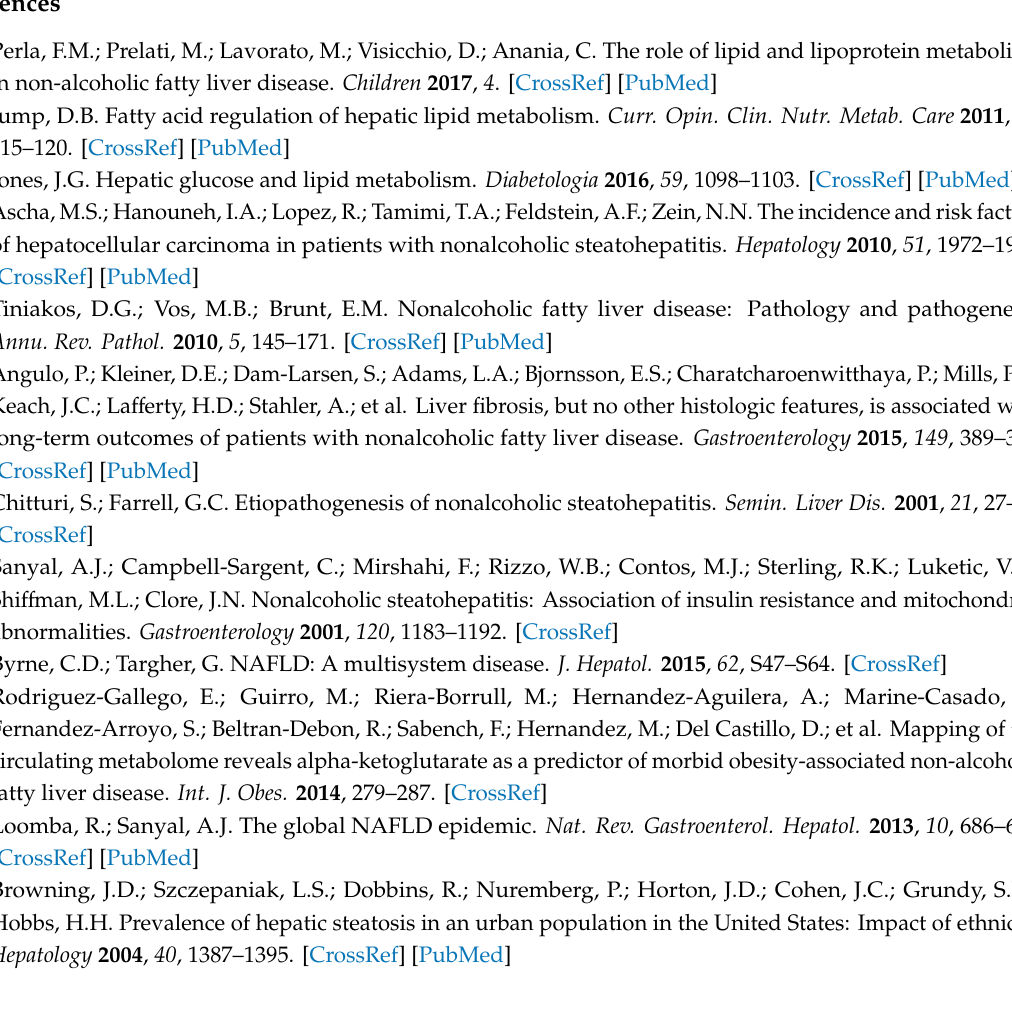
keywords. Supplementary Datasets Table S2: Expression fold change of lipid related genes found di ff erentially expressed between NASH and healthy obese liver samples. Supplementary Datasets Table S3: Liver as principal filter for prioritization of lipid related genes found di ff erentially expressed in NASH. Supplementary Datasets Table S4: Gene prioritization secondary filters (immunological, inflammation, liver pathogenesis progression) table found with lipid related genes di ff erentially expressed in NASH. Supplementary Datasets Table S5: Identification of protein partners of YWHAZ gene using InnateDB database. In red, “ YWHAZ gene encodes for a 14-3-3 protein family and it is well known to be up-regulated in